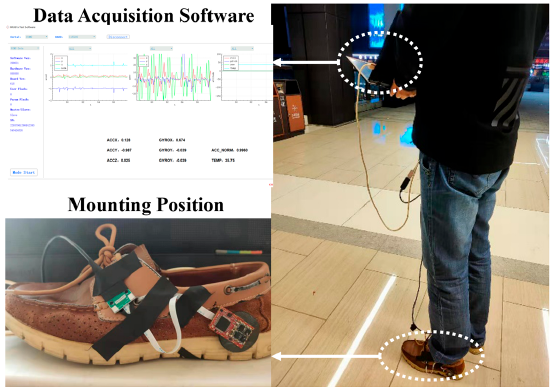
Figure 11. Closed-loop experiments scenes based on foot-mounted IMU array.